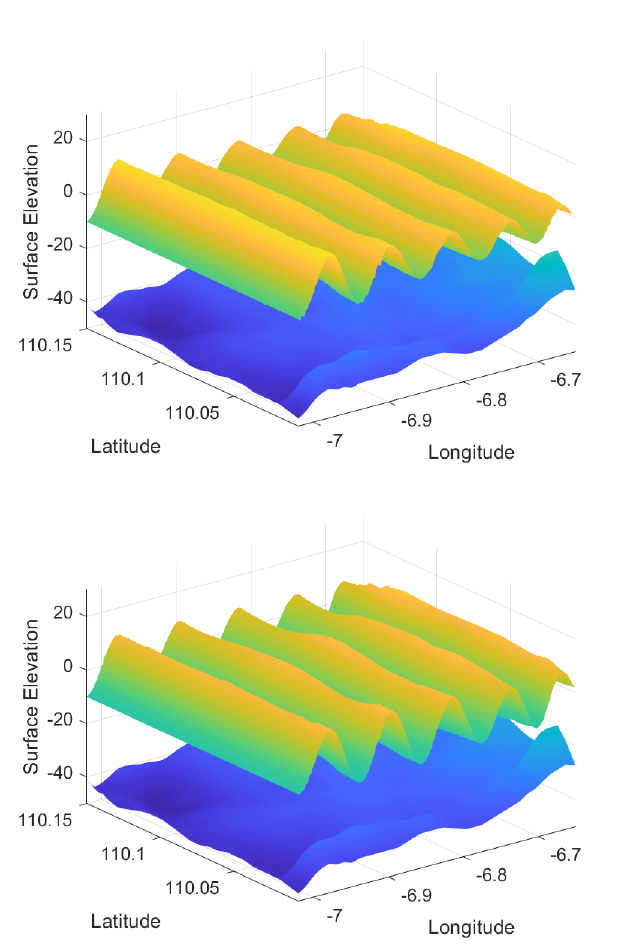
Figure 13. 2-D Numerical Simulation of Wave Propagation Phenomenon with Real Bathymetry Profile using ( upper ) Friction-Coefficient c f = 0.32 ( lower ) Diffusion-Coefficient, c D =